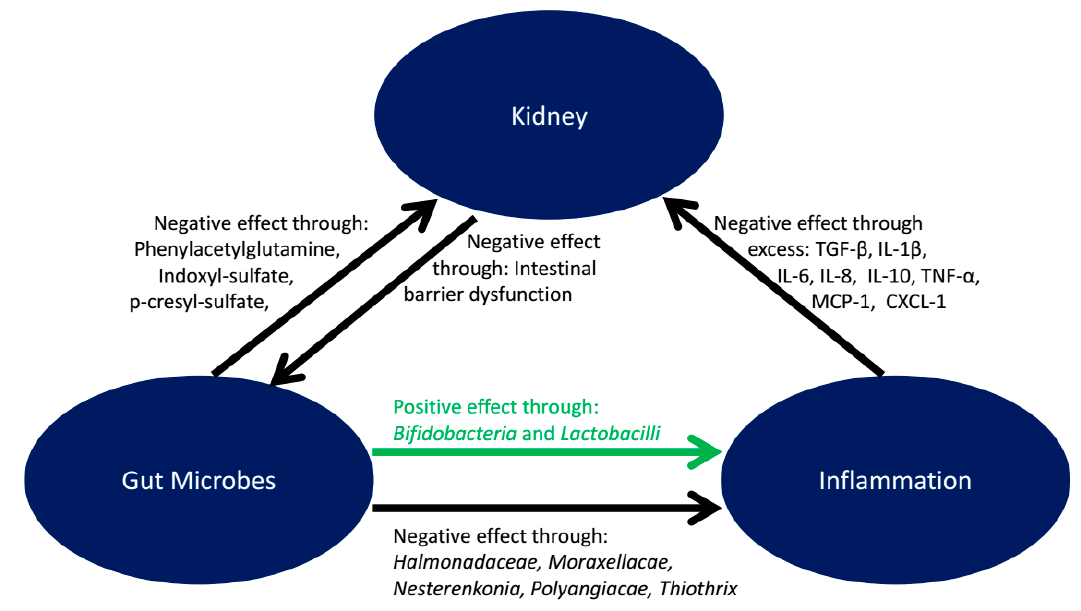
Figure 1. The relationship between gut microbes, inflammation, and kidney function. A schematic representation of the role of inflammation and gut microbes on kidney function. Inflammation in aging is mediated by increased levels of members from the cytokine and chemokine families. The negative effects of the gut microbial products including p-cresyl sulfate and indoxyl sulfate may induce kidney dysfunction directly or through these uremic toxin-mediated inflammation. The beneficial effects of the gut bacteria especially Bifidobacteria , on kidney function, may be through its effects by increasing the levels of anti-inflammatory cytokine IL-10. Dietary interventions to reduce such uremic toxins by modulating the gut microbiome may be an important area of research to attenuate the deleterious effects of aging. (Abbreviations: Transforming grow factor- β (TGF- β ); IL-1- β (Interleukin-1 β ); IL-6 (Interleukin-6); IL-8 (Interleukin-8); IL-10 (Interleukin-10); TNF- α (Tumor necrosis factor- α ); MCP-1 (Monocyte chemoattractant protein-1); CXCL-1 (Chemokine (C-X-C-motif) ligand 1)).